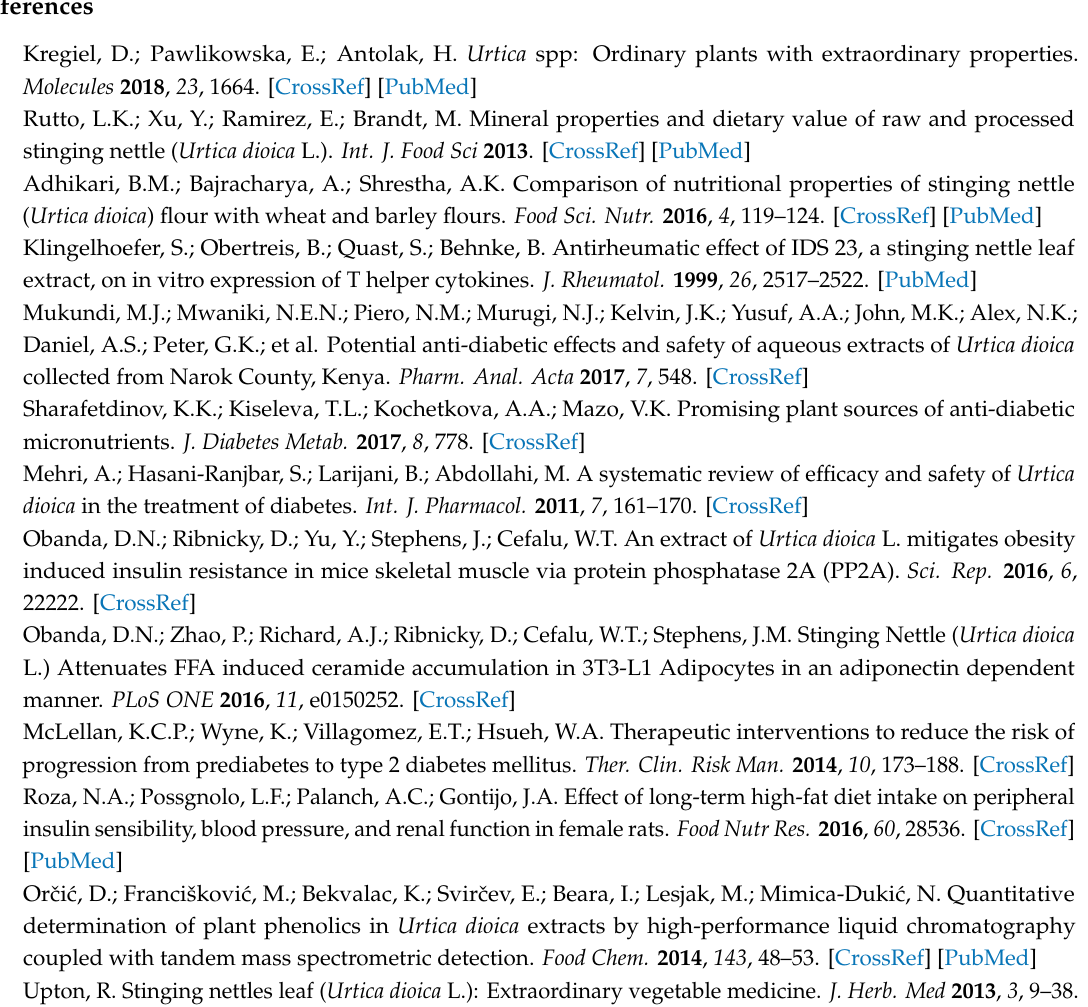
Table S1: Primers used for qPCR, Table S2: Nutrient Analysis of leaves and stems of Urtica dioica L, Table S3: Fatty acid profile of the leaves and stems of Urtica dioica L, Table S4: Relative fold changes in expression of genes that are involved or impact insulin signaling in skeletal